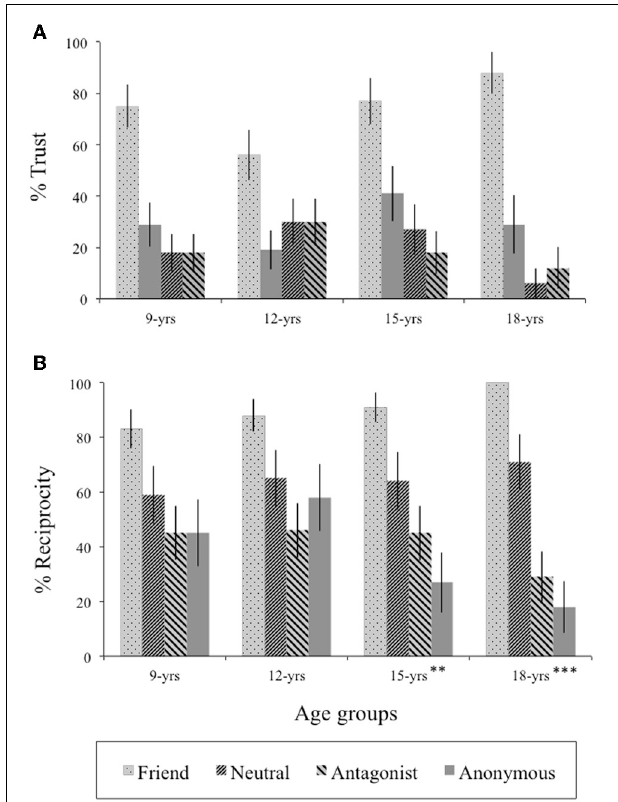
FIGURE 4 | Prosocial behavior (trust and reciprocity) in the Trust game. Mean frequency (%) and standard errors of (A) trust and (B) reciprocity choices in the Trust game are presented per interaction partner for the four age groups. Age differences are indicated by an asterisk ( ∗ ). ∗∗ p < 0 . 01, ∗∗∗ p < 0 . 001.